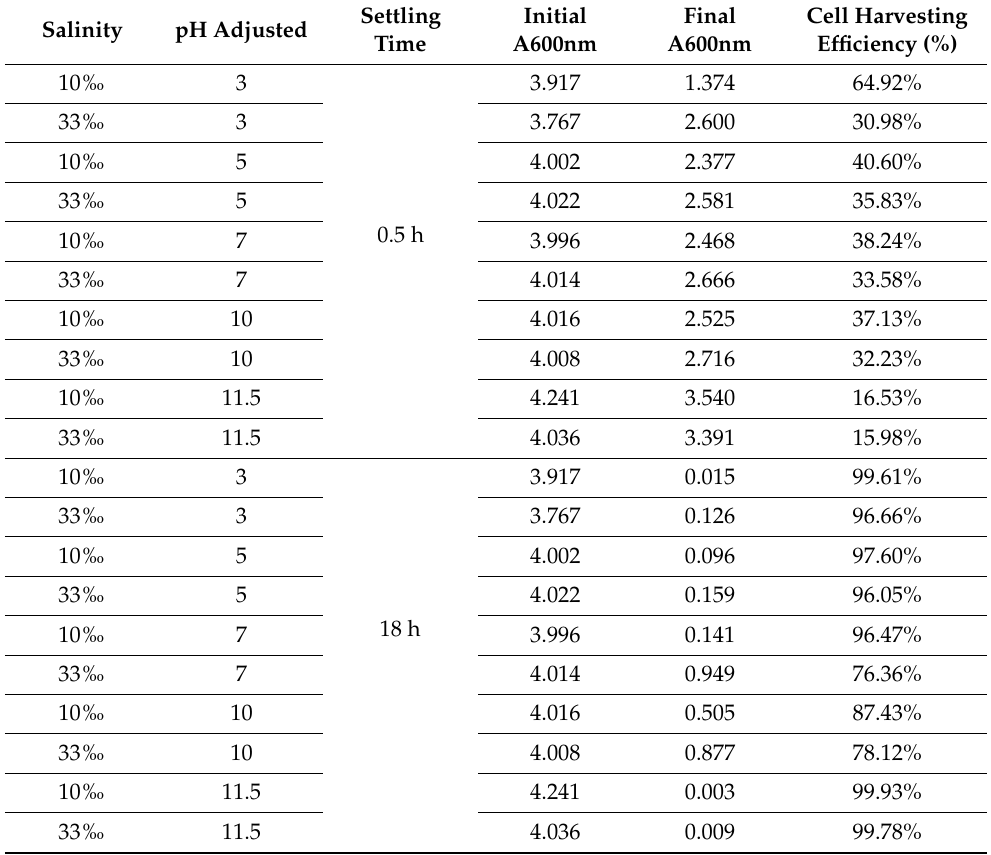
Table 2. Cell harvesting efficiency at different pH conditions used for